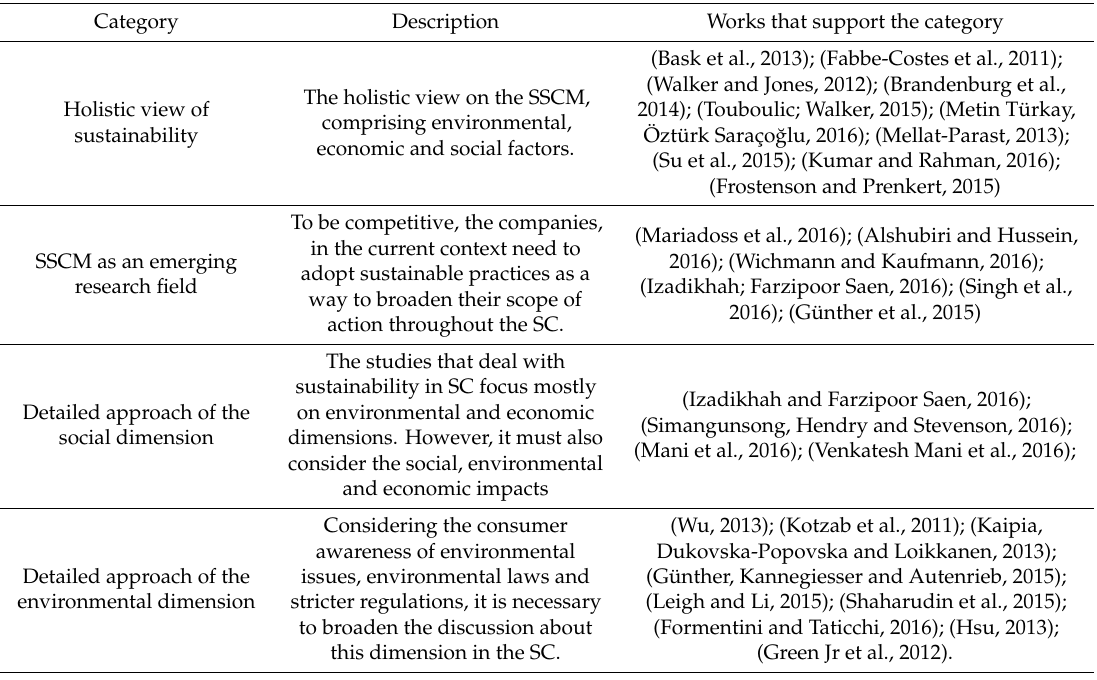
Table 3. Categorization of the articles